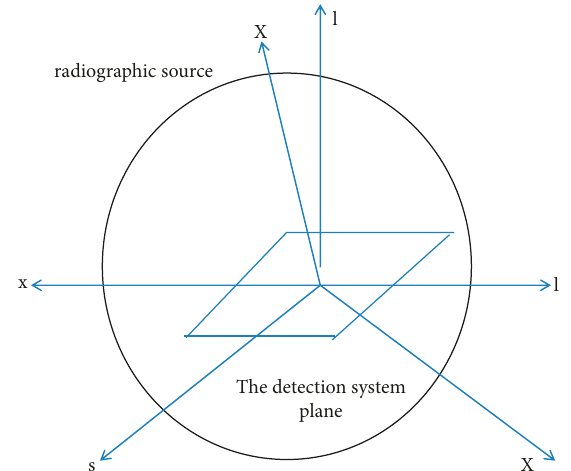
Figure 2: Geometric coordinate relationship of cone-beam pattern scanning